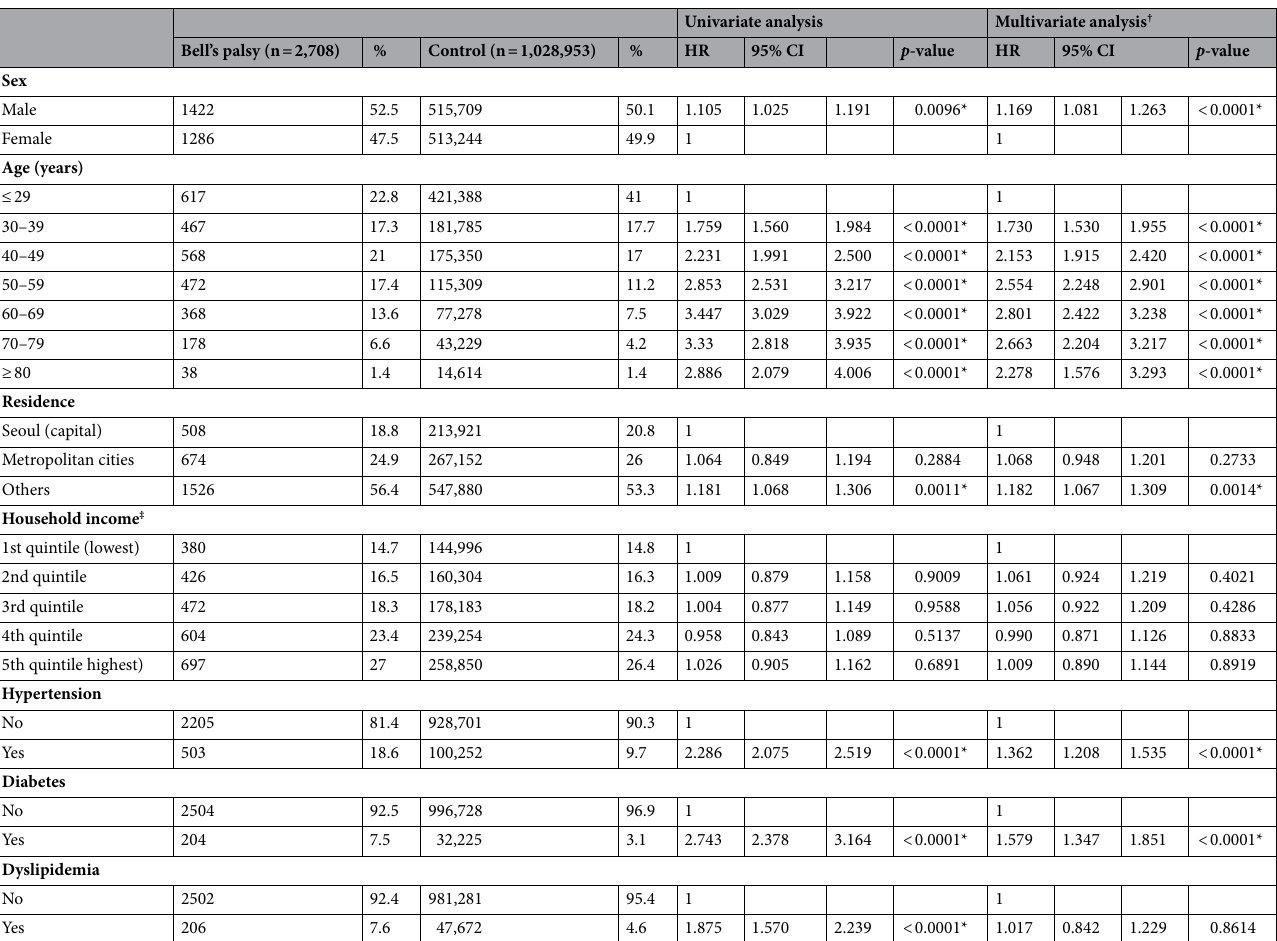
Table 3. Risk factors for Bell’s palsy based on univariate and multivariate Cox proportional hazard regression analyses. HR hazard ratio, CI confidence interval. * p value < 0.05. † All factors were adjusted in the multivariate Cox proportional hazard regression analysis. ‡ The sum of patients in household income is less than the total due to missing